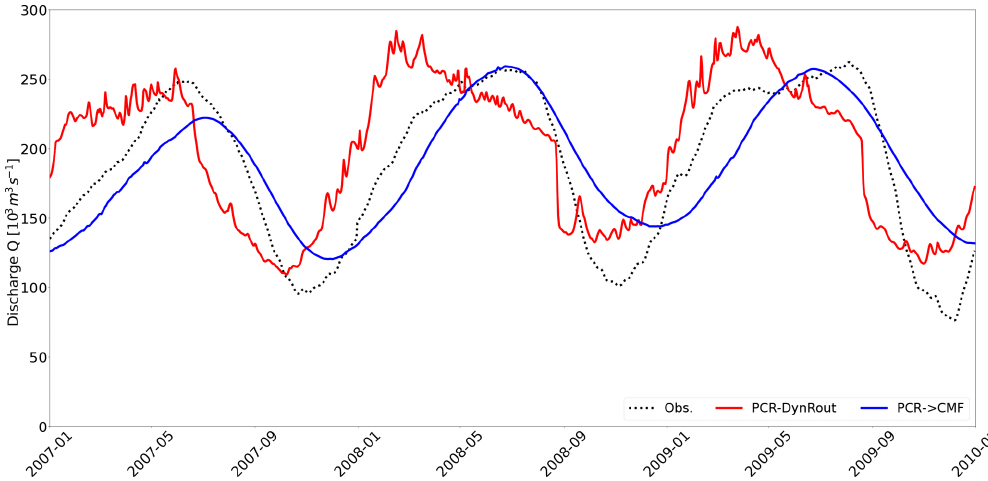
Figure 3. Simulated discharge by PCR-DynRout and PCR → CMF as well as observed discharge at Óbidos.